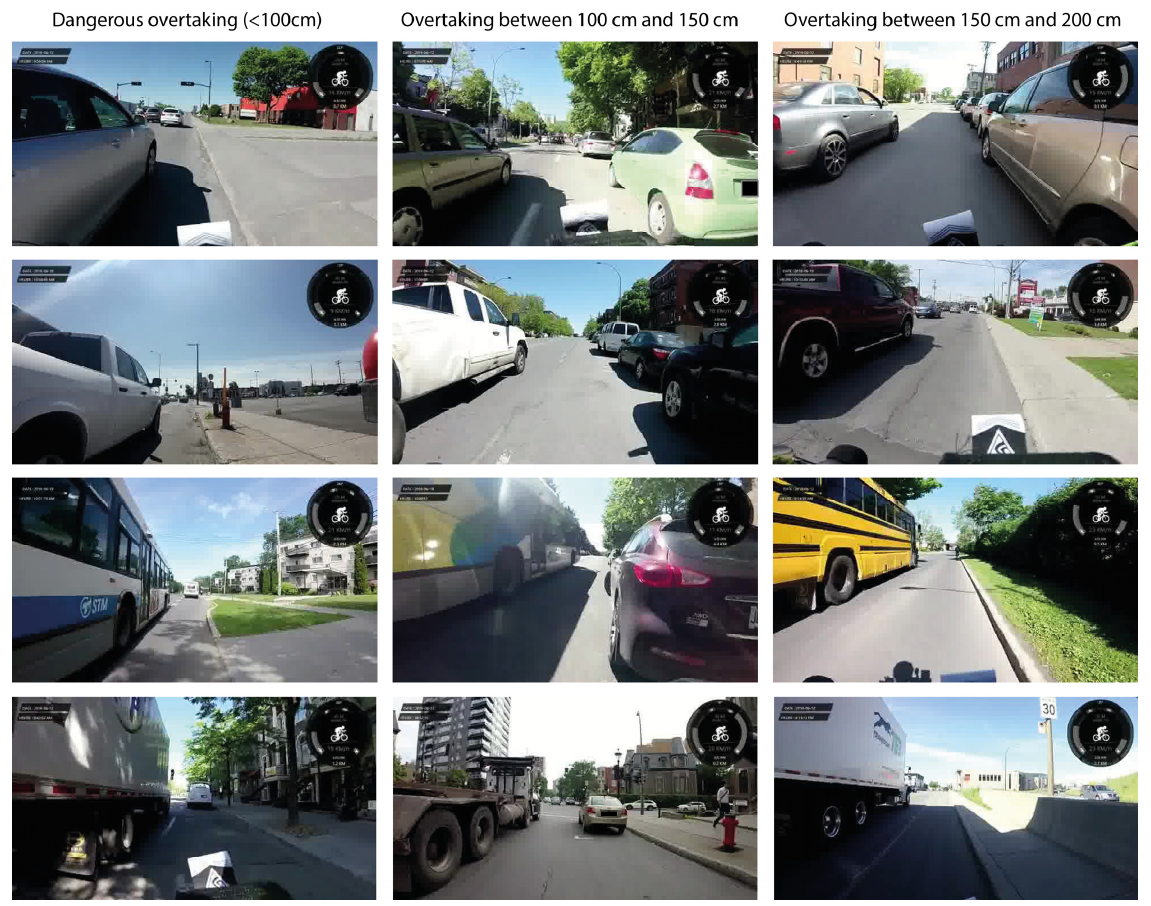
Figure 7. Different overtakings according to types of vehicles and LPD.